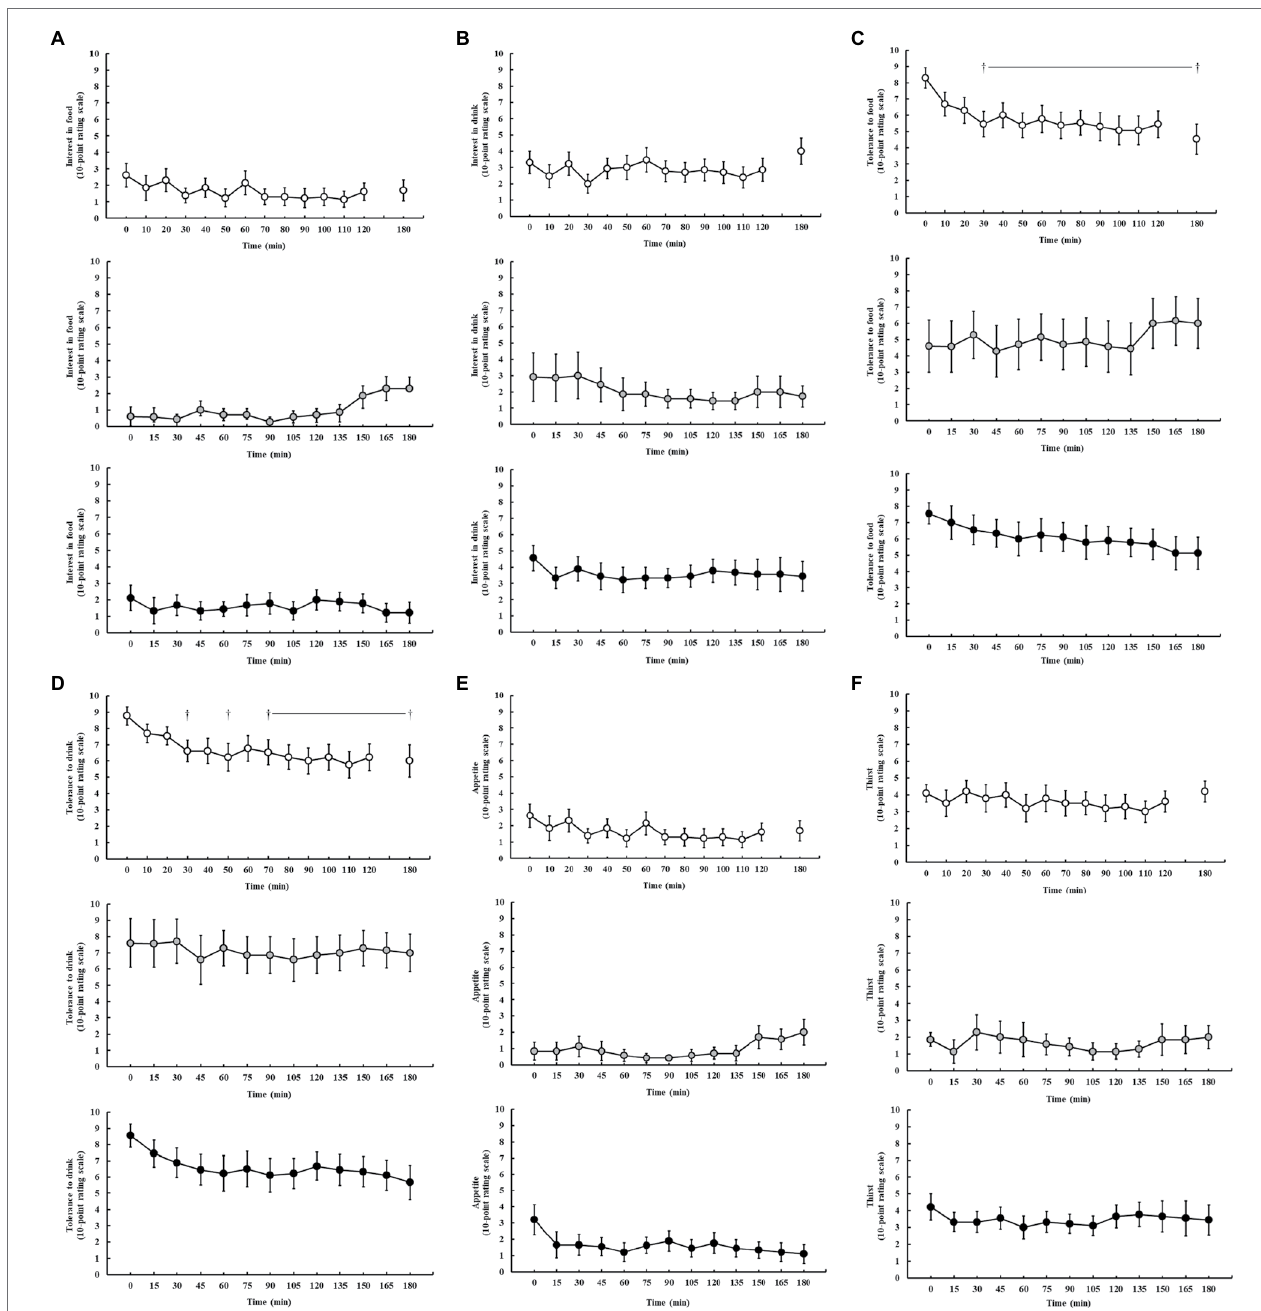
FIGURE 4 | Feeding tolerance markers, including interest in food (A) , interest in drink (B) , tolerance to food (C) , tolerance to drink (D) , appetite (E) , and thirst (F) , rated on a 10-point Likert-type rating scale (Miall et al., 2018), during steady-state running with CHO provision on P1 ( ○ ), P2 ( ● ), and P3 ( ● ). Mean ± SEM ( n = 28): † p < 0.05 vs. pre-exercise (0 min) resting feeding tolerance. P1: formulated gel-disc containing 30 g CHO with 300 ml water (10% w/v , 90 g/h, 2:1 glucose–fructose, 316 mOsmol/kg), at 0 min and every 20 min thereafter for 120 min; followed by water provisions ad libitum for the 3rd h (270 ± 215 ml). P2: CHO beverage containing 25 ± 3 g CHO (10% w/v , 76 ± 8 g/h, 509 mOsmol/kg; equivalent to 1.0 g/kgBM/h) at 0 min and every 20 min thereafter for 120 min, then water provisions ad libitum for the 3rd h (170 ± 122 ml). P3: CHO beverage containing 45 g CHO (16% w/v , 90 g/h, 2:1 glucose–fructose, 460 mOsmol/kg), at 0 min and every 30 min thereafter for 180 min. Water provisioned ad libitum , but not consumed by participants (0 ± 0